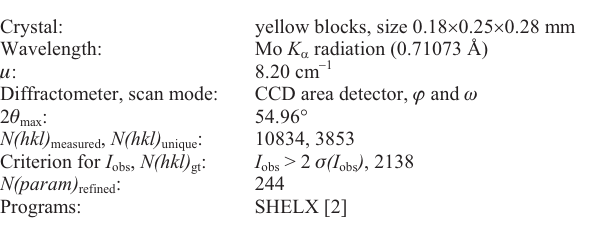
Table 1. Data collection and handling.